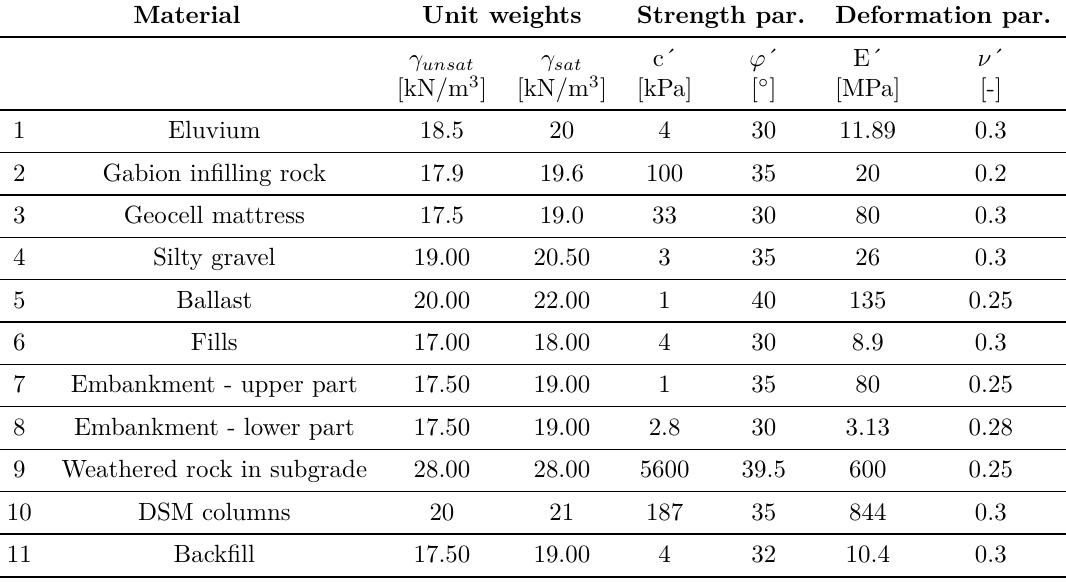
Table 1. Input values of MC constitutive model